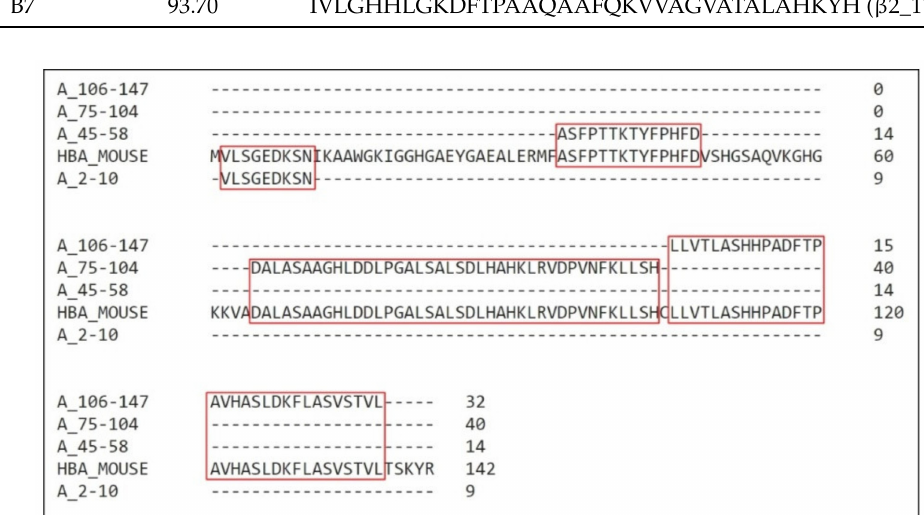
Figure 2. Coverage of Mus musculus α hemoglobin sequence. Alignment of the fragments obtained through mass spectrometry with the mouse hemoglobin α chain. Sequence compilations were performed to avoid residues repetitions. The residues coverage is highlighted in